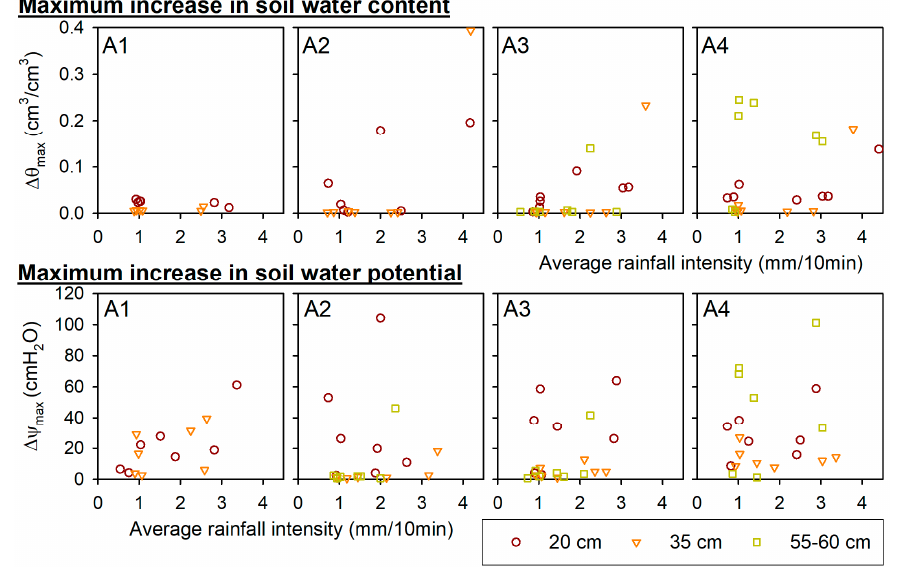
Figure 7. Relationship of the maximum increase in soil water content ( Δθ max ) and soil water potential ( Δψ max ) at each point on measurement lines A1–A4 to the average rainfall intensity when Δθ max or Δψ max was reached at a 10 min measurement interval during the effective rainfall events.